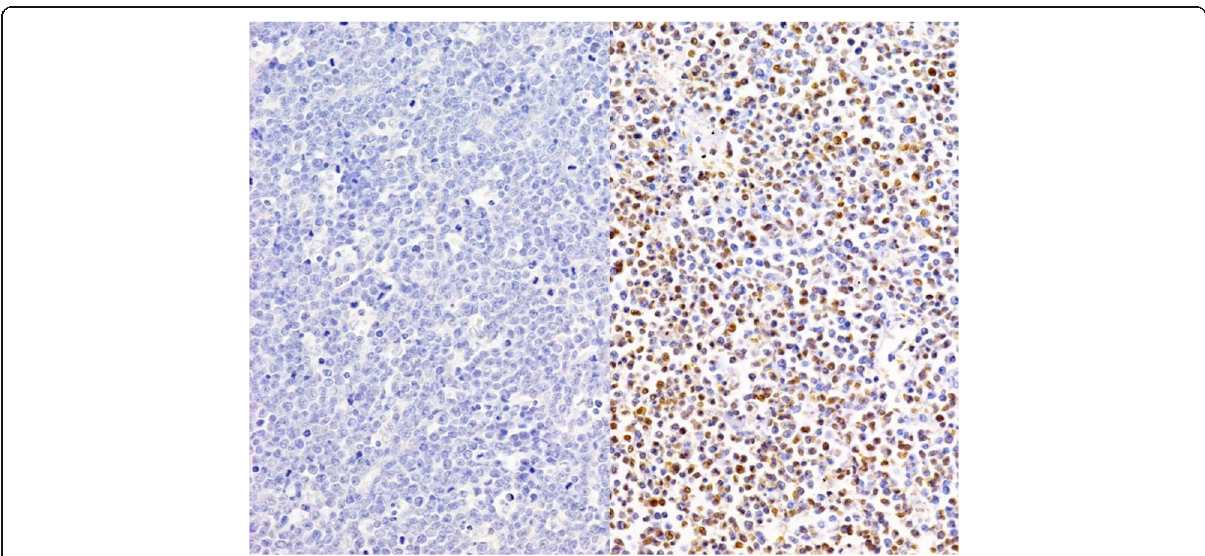
Fig. 4 Left: Epstein-Barr virus-encoded small RNA (EBER) in situ hybridization of thyroid Burkitt ’ s lymphoma. The tumor cells are negative for Epstein-Barr virus (EBV) (×200). Right: EBER in situ hybridization of nasopharyngeal carcinoma, which was used as external positive control. The tumor cells are positive for EBV (× 200)